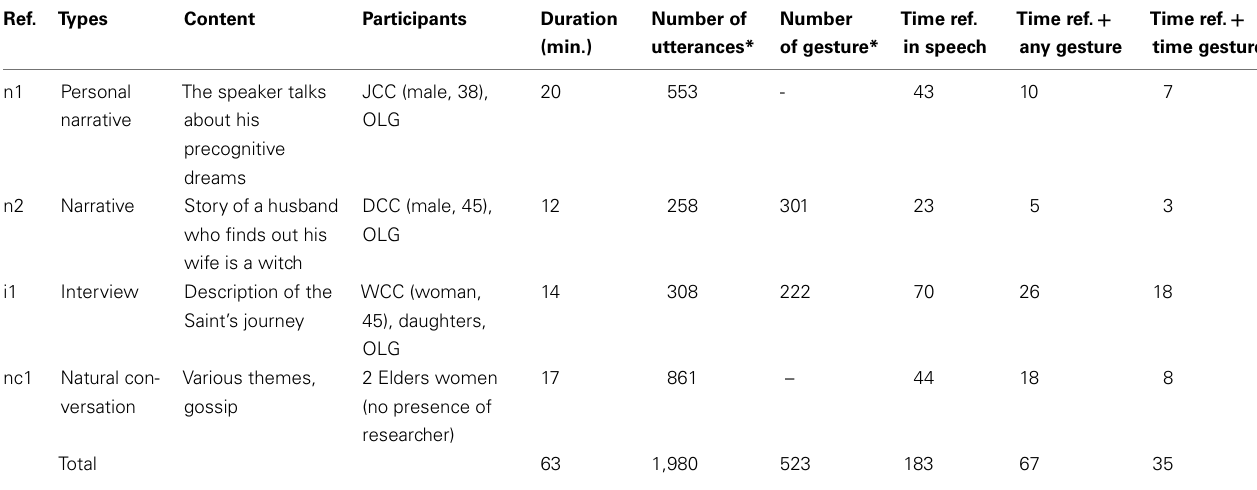
Table 3 | Data of spontaneous